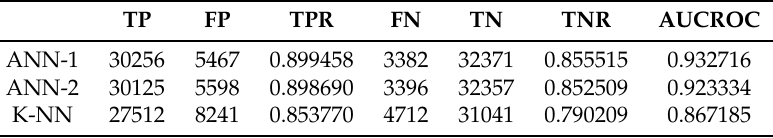
Table 5. Comparative sensitivity and specificity of the three models.